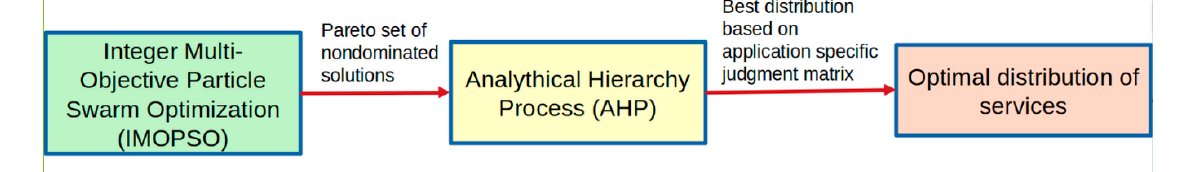
Figure 8. Flow chart of the service placement finding method.